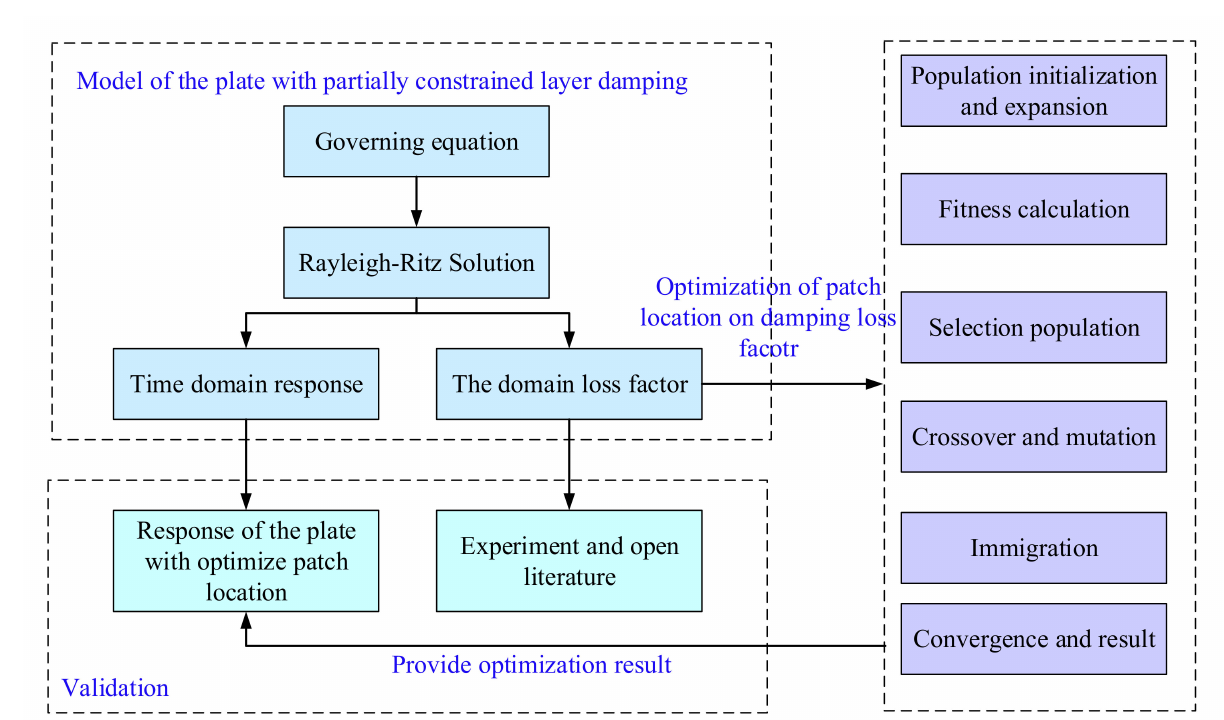
Figure 3. Research structure of this